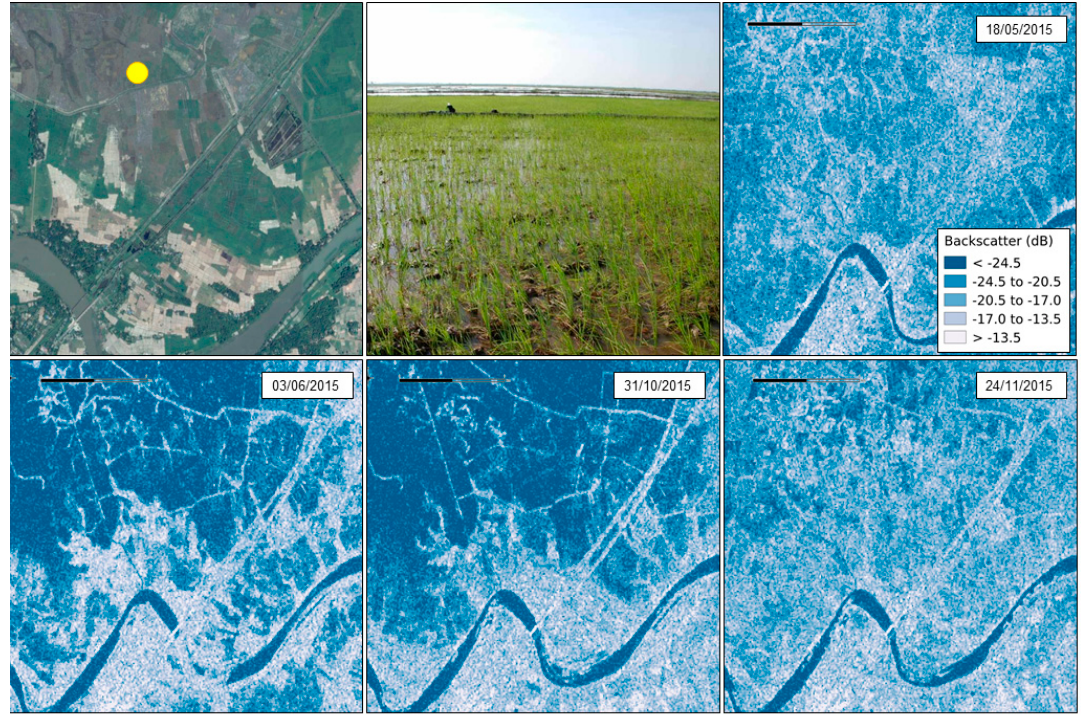
Figure 2. Example geofield photo and time series Sentinel-1 backscatter dB illustrating dynamic inundation (blue tones). Table 2. Characteristics of training data used for the Classification And Regression Tree to generate a broad class map.